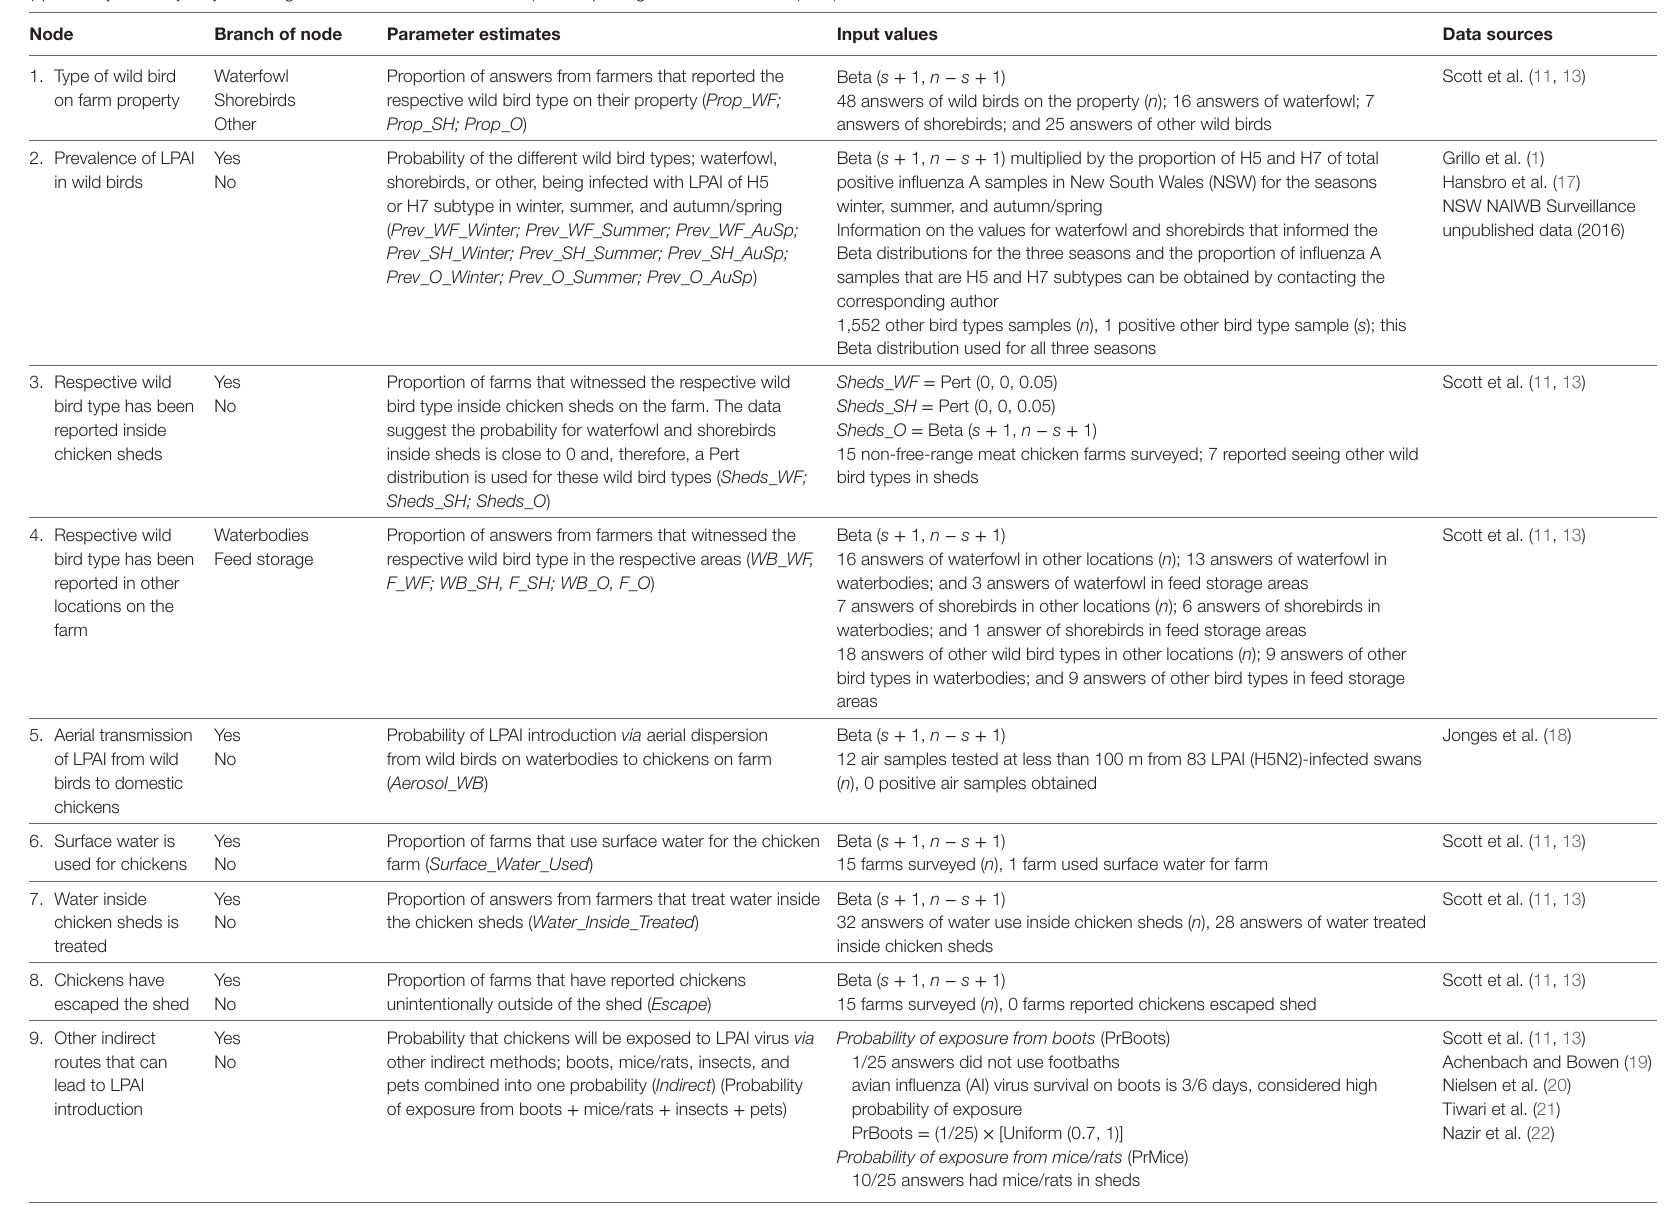
TaBle 1 | Nodes, parameter estimates, and input values used for the exposure assessment estimating the probability of exposure of commercial chickens on non-free-range meat chicken farms in Australia (specifically in the Sydney basin region and South East Queensland) to low pathogenic avian influenza (LPAI) from wild